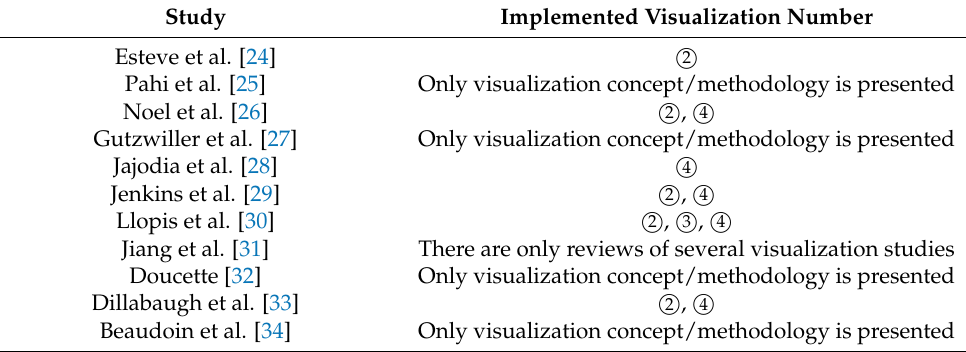
Table 2. Visualization Implementation Status in CyCOP